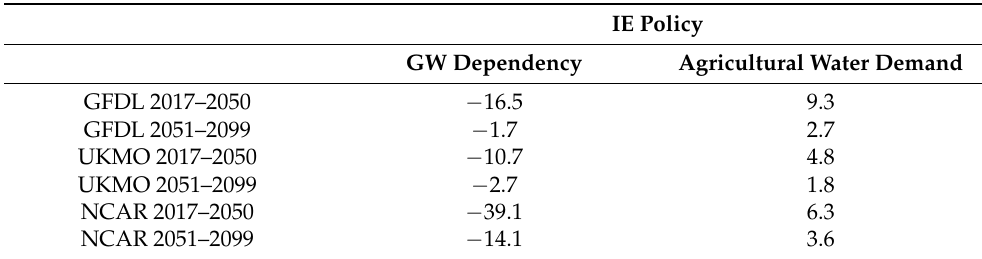
Table 4. Relative changes of groundwater dependency and agricultural water demand between scenarios and base runs